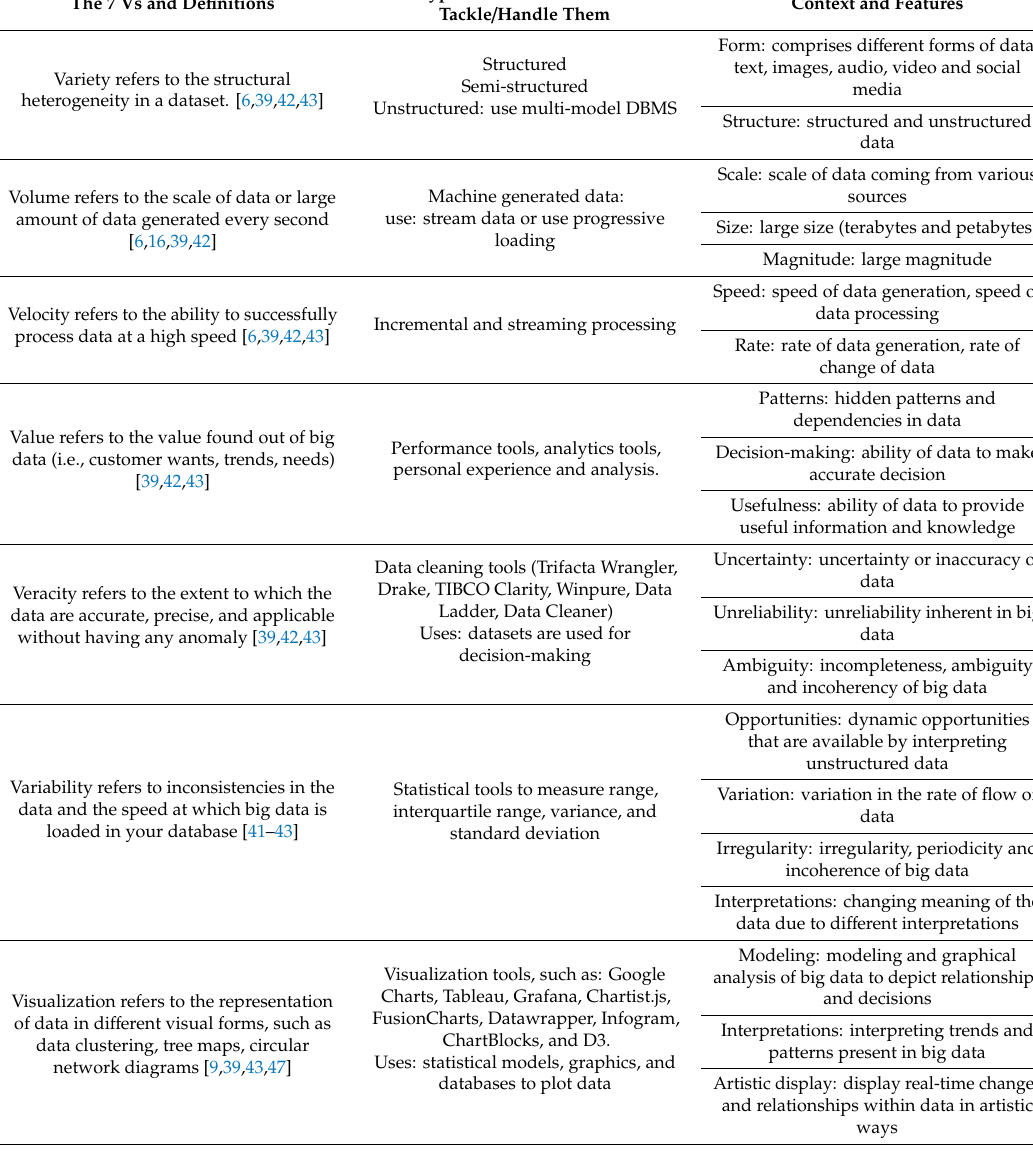
Table 6. The seven Vs, as well as their key aspects and context of